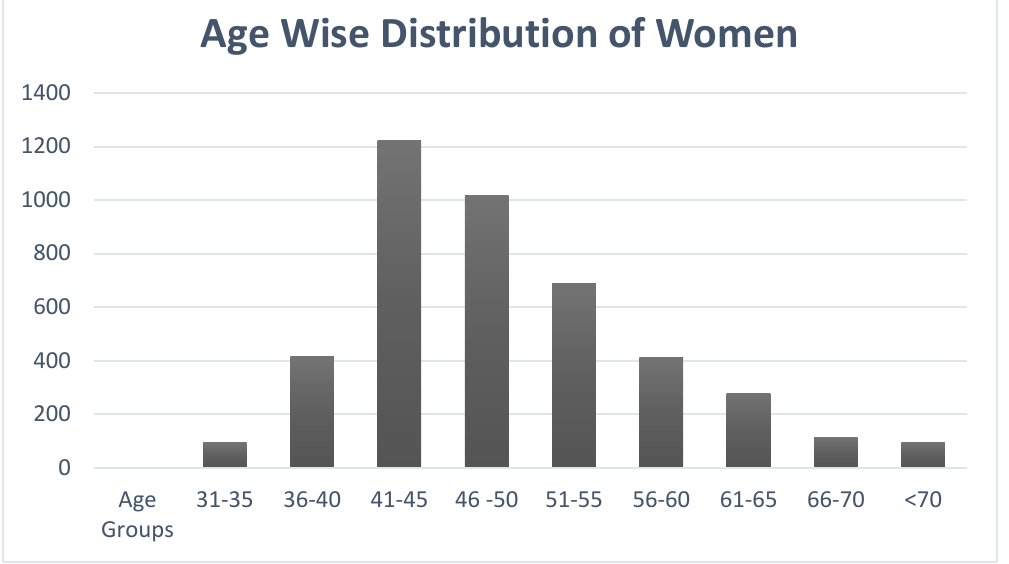
Figure 4. The age-wise distribution of women visiting for mammography screening.